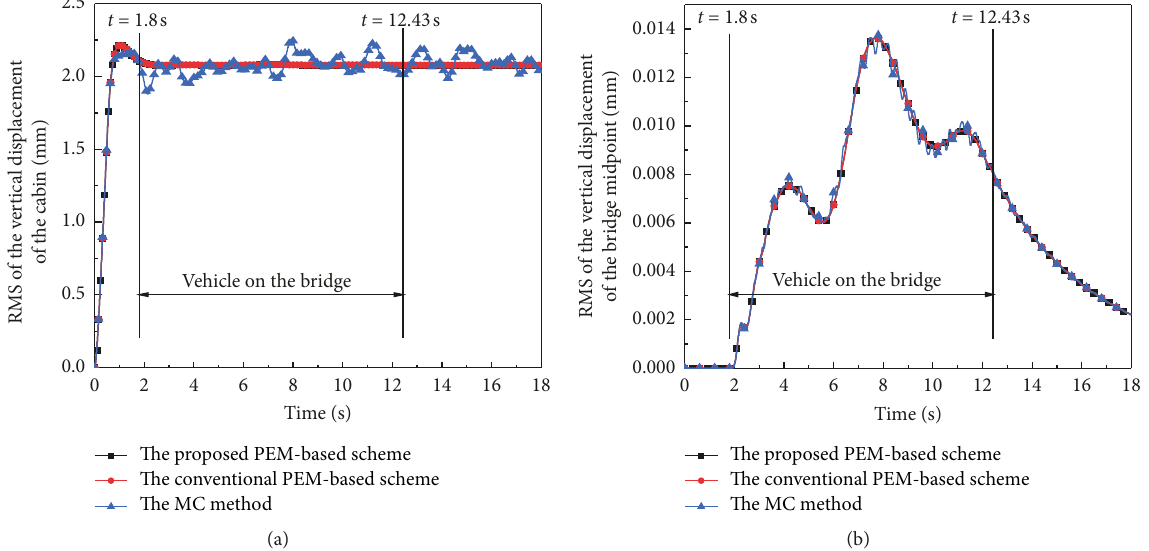
Figure 5: RMSs of vertical displacements for (a) the cabin and (b) the bridge midpoint when the maglev vehicle with one car moves on the bridge at the speed of 100 km/h.